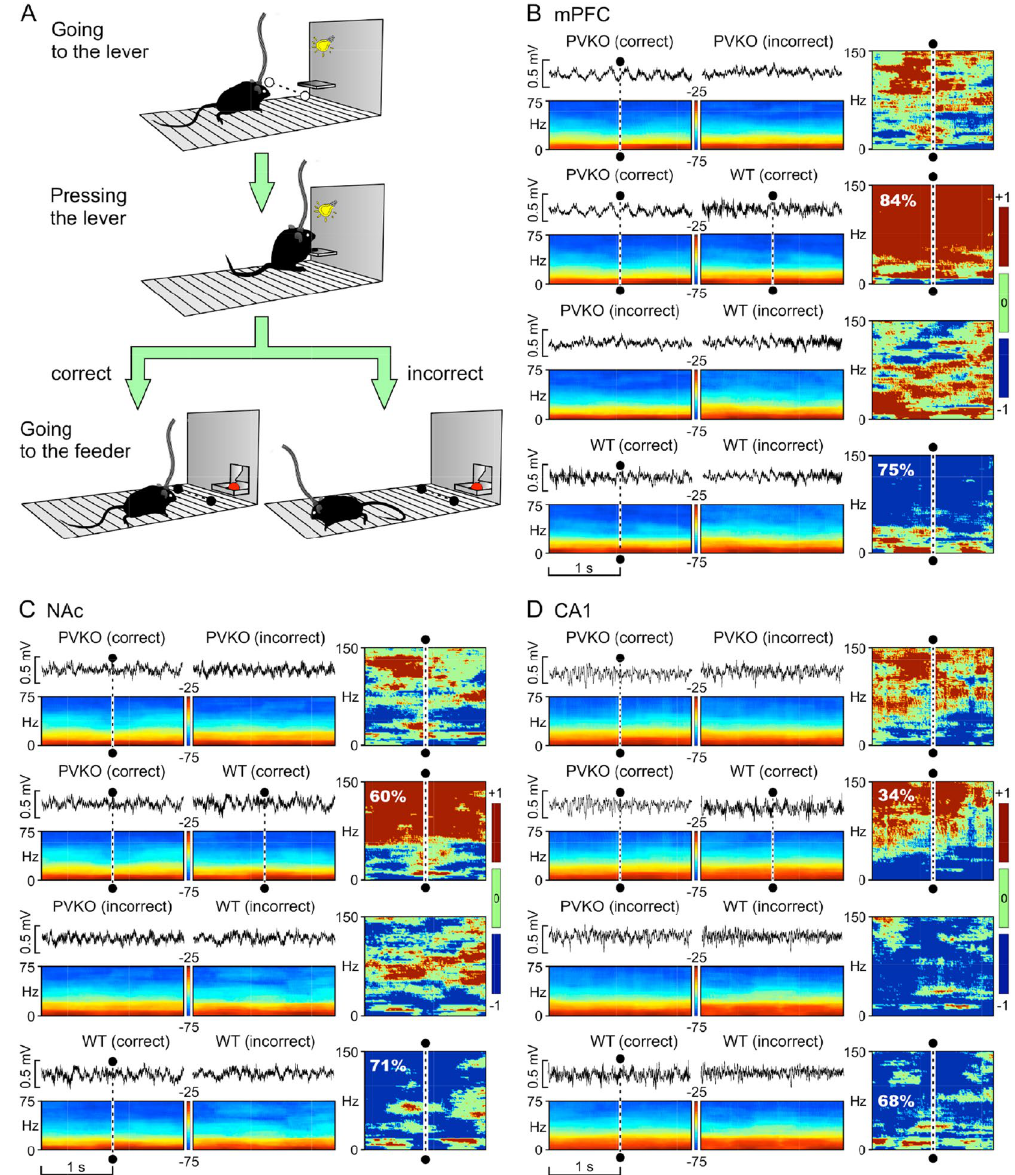
Figure 3. Differences in LFPs recorded at mPFC, NAc and CA1 from WT and PVKO mice during the correct or incorrect outcome of the operant conditioning trial. ( A ) Comparison of LFPs recorded when mice, after pressing the lever, approached (correct behavior) or not (incorrect behavior) the feeder. ( B ) Comparison of the dynamic changes in LFP recorded at the mPFC in WT and PVKO mice during the correct or incorrect conclusion of the operant conditioning task. From top to bottom are illustrated four different comparisons corresponding to WT and PVKO mice and to the correct or incorrect conclusion of the task. Within each panel are illustrated the selected animal group and behavior and a representative example of the recorded LFP activity corresponding to the same time window. An average of 8 samples: time/frequency representation of this LFP activity is illustrated below (frequency range, 0–75 Hz). When present, the dashed line indicates the moment of light beam crossing (black dots and dashed line). At the right of each panel is shown the probabilistic map (frequency range, 0–150 Hz) corresponding to the comparison of the two spectrograms located at the left. In these probabilistic maps, the blue [inference type − 1; the power in first (most leftward) spectrogram ≫ the power in second (rightward) spectrogram] and brown [inference type + 1; the power in first (most leftward) spectrogram ≪ the power in second (rightward) spectrogram] colors denote significant ( P < 0.05 ; jackknifed estimates of the variance) statistical differences, while the green color (inference type 0; the power in first spectrogram ≈ the power in second spectrogram) indicates no significant ( P > 0.05 ) differences. ( C ) Comparison for LFPs recorded in the NAc, as presented in ( B ). ( D ) Comparison for LFPs recorded in the hippocampal CA1 area, as presented in panel ( B ). For more details see Supplementary Table